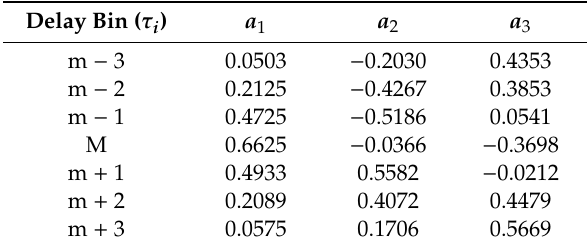
Table 1. Coe ffi cients a N for deriving the generalized linear observables (GLOs) using the principal component analysis (PCA) method